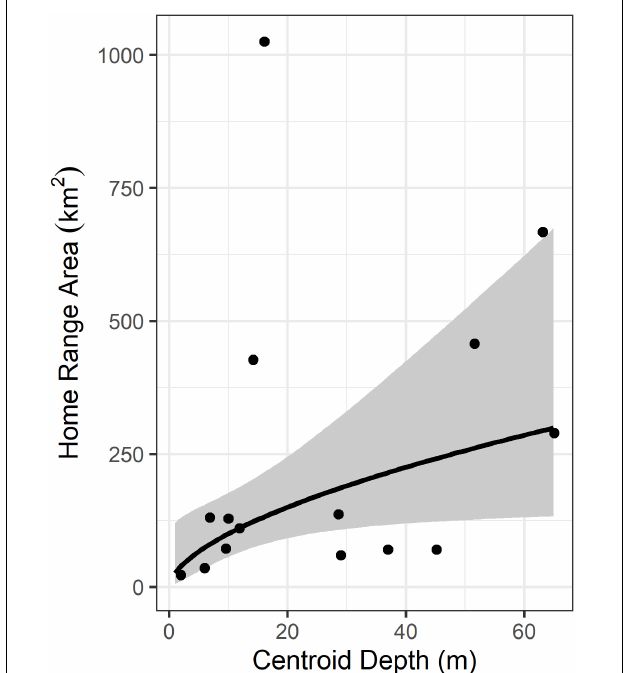
FIGURE 2 | Relationship between home range size (95% KDE) and depth. Fit line is from a linear model where ln(area) depends on ln(depth) and is significant ( p = 0.04, adj- R 2 = 0.23). Shaded envelope represents the 95% confidence interval around the fit